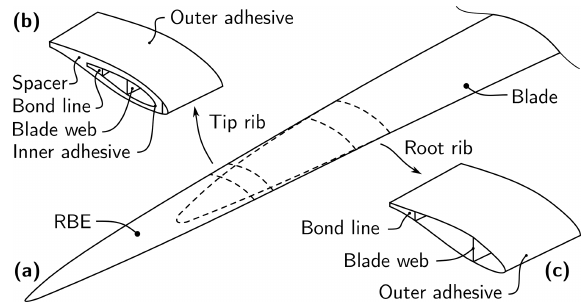
Figure 1. Design concept of a rotor blade extension. (a) Assembly of blade and extension (RBE), (b) tipward bonding connection (Tip rib), and (c) rootward bonding connection (Root